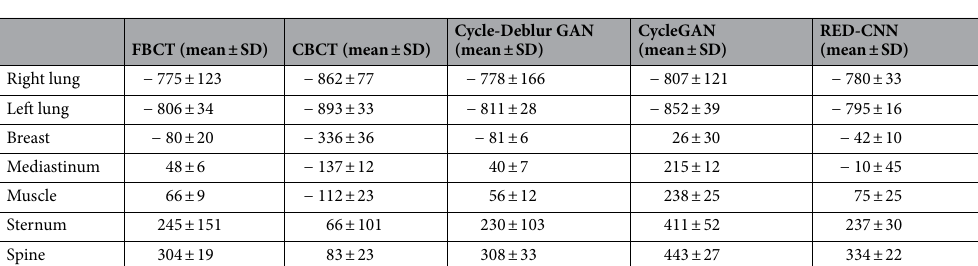
Table 1. The CT value comparison of different ROIs.